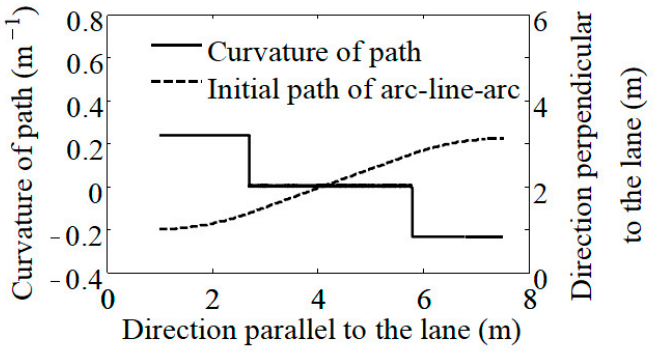
Figure 13. Curvature change of arc-line-arc path.